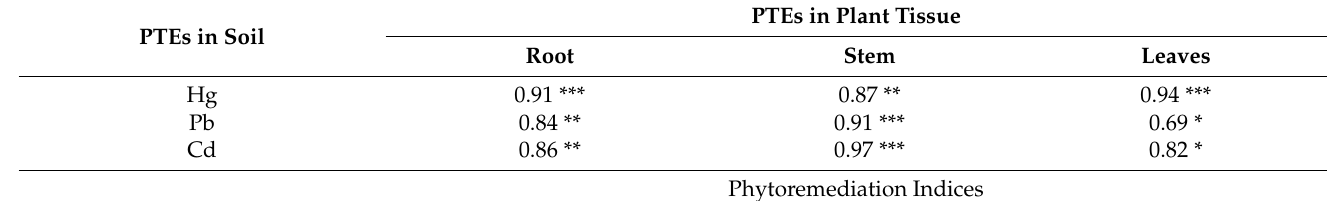
Table 3. Pearson correlation coefficients ( r -value) between PTEs in soils and in tissues of C. sericea and chemical characteristics of soil and PTEs phytoremediation indices ( n = 12). PTEs in Plant